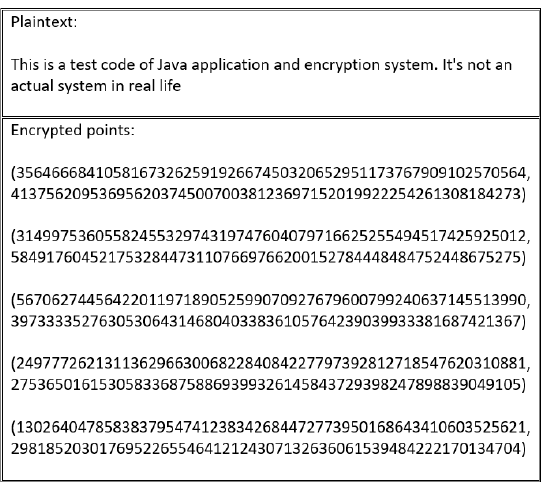
Figure 19. Cipher text generated by second encryption process with XOR different InV using the same plain text as in Figure